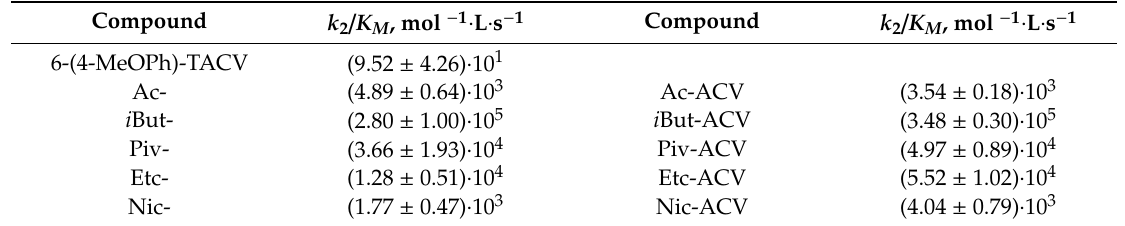
Table 4. Parameters describing the dependence of k obs. = f ( c E ) of the hydrolysis reaction of the tested compounds in human plasma in the presence of the porcine esterase (37 ◦